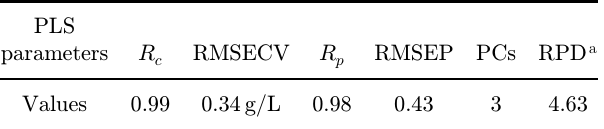
Table 3. The performance of PLS model within 6000 – 5970 cm (cid:3) 1 and parameters